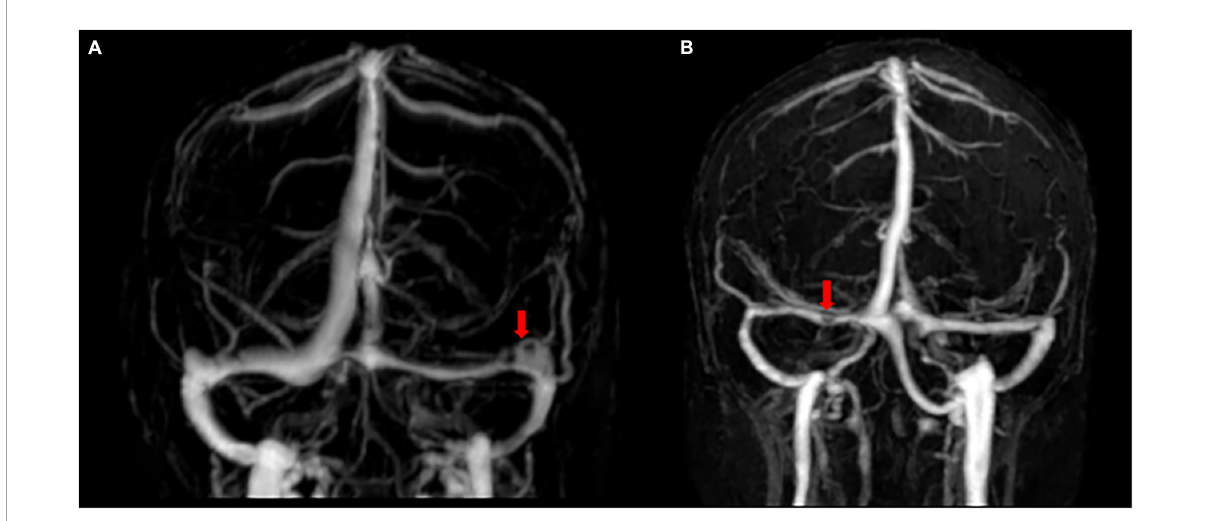
FIGURE3 Flow gaps and arachnoid granulations in cerebral venous sinus using contrast-enhanced-magnetic resonance venography. (A) Two flow gaps are on the non-dominant side and at the junction of the sigmoid sinus and the transverse sinus (TS). (B) A small flow gap is on the proximal TS. After evaluation by radiologists, these flow gaps were considered to be arachnoid